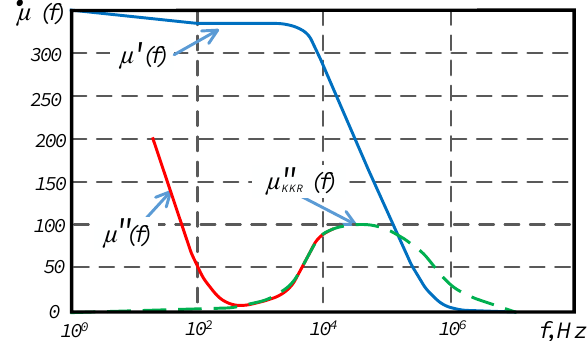
Fig. 8. Analysis of CIP of Ni 0.55 Zn 0.45 Fe 2 O 4 ferrite [11].